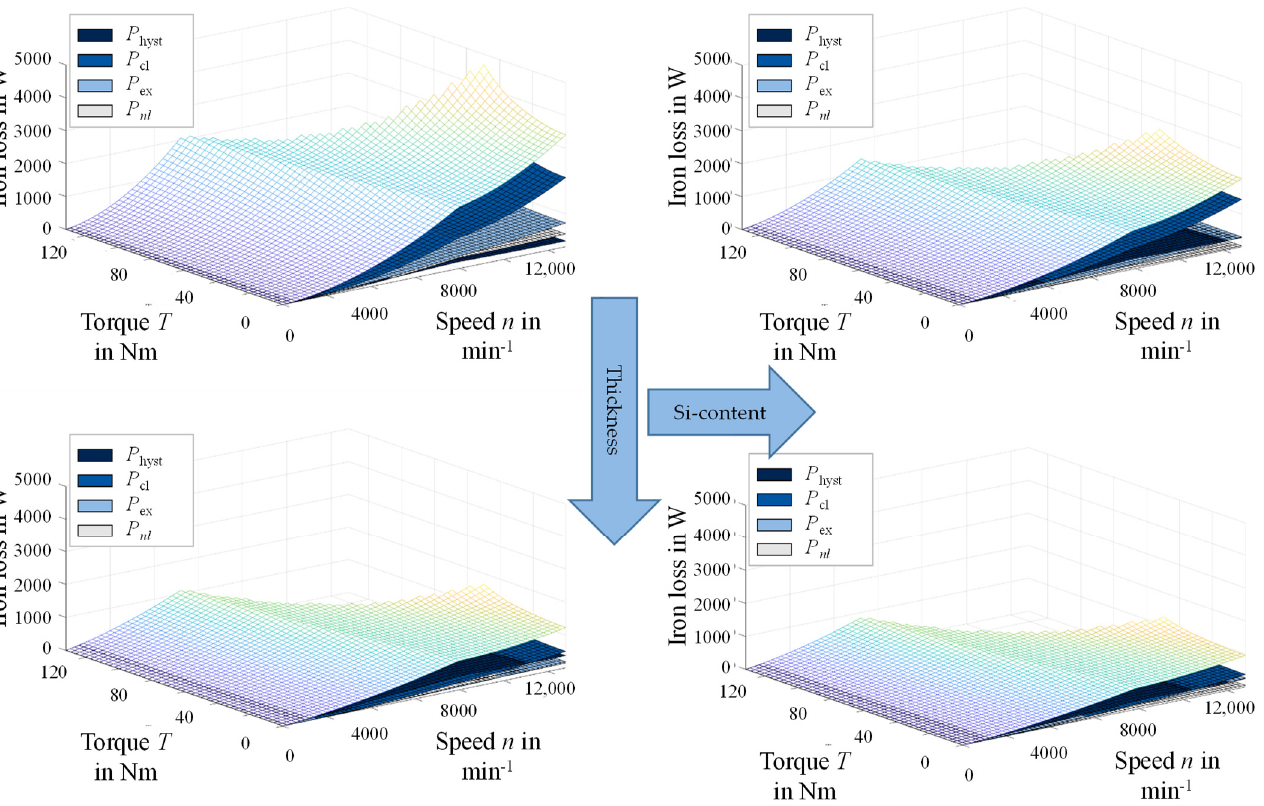
Figure 11. Simulation study results of total iron loss in a torque–speed map: ( a ) 1b— Fe–2.4 wt % Si, 0.5 mm, 265 µm; ( b ) 2g–Fe 3.2 wt % Si, 0.5 mm, 43 µm; ( c ) 1d—Fe–2.4 wt % Si, 0.25 mm, 37 µm; ( d ) 2k—Fe–3.2 wt % Si, 0.25 mm, 162 µm, nomenclature according to Tables 1–3.